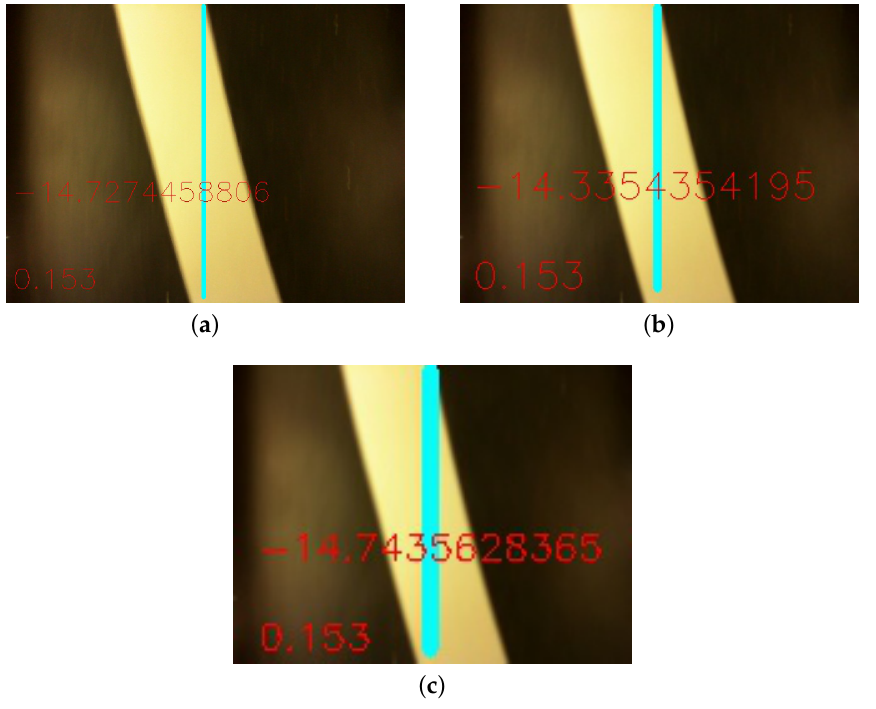
Figure 21. Angle and distance measurements in different resolution. Images do not follow their real sizes. ( a ) size: 640 × 480. θ AGV (cid:117) − 14.727446 ◦ and d AGV = 0.153 cm; ( b ) size: 320 × 240. θ AGV (cid:117) − 14.335435 ◦ and d AGV = 0.153 cm; ( c ) size: 160 × 120. θ AGV (cid:117) − 14.743563 ◦ and d AGV = 0.153